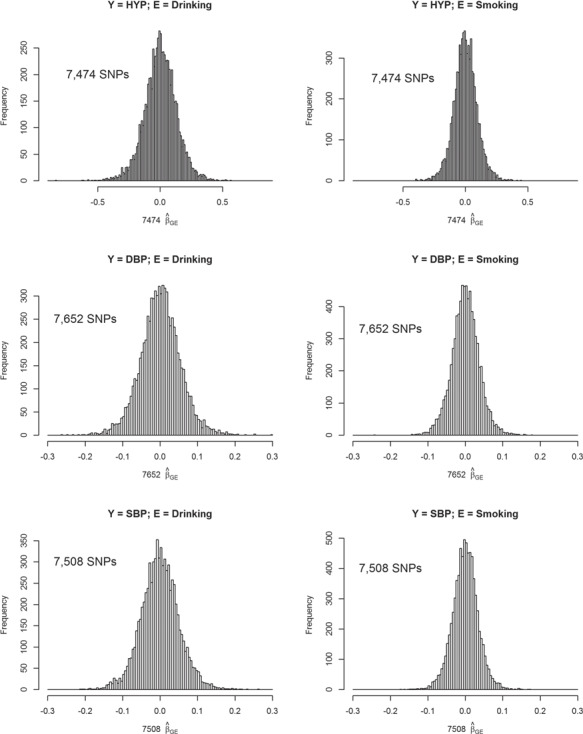
Histograms of \documentclass[12pt]{minimal}
\usepackage{amsmath}
\usepackage{wasysym}
\usepackage{amsfonts}
\usepackage{amssymb}
\usepackage{amsbsy}
\usepackage{upgreek}
\usepackage{mathrsfs}
\setlength{\oddsidemargin}{-69pt}
\begin{document}
}{}${\widehat{\beta}}_{GE}$\end{document}s for SNPs that passed the pruning and screening stages. In total, 7474, 7652 and 7508 SNPs passed the pruning and screening stages for analyses of HYP (a binary trait), DBP and SBP, respectively. These SNPs were analyzed according to Equation (2), in which age, gender, BMI and the 1st seven PCs were adjusted. Two binary Es including alcohol drinking (left column) and smoking (right column) were considered. Here we show the histograms of \documentclass[12pt]{minimal}
\usepackage{amsmath}
\usepackage{wasysym}
\usepackage{amsfonts}
\usepackage{amssymb}
\usepackage{amsbsy}
\usepackage{upgreek}
\usepackage{mathrsfs}
\setlength{\oddsidemargin}{-69pt}
\begin{document}
}{}${\widehat{\beta}}_{GE}$\end{document}s from the GLM in Equation (2).